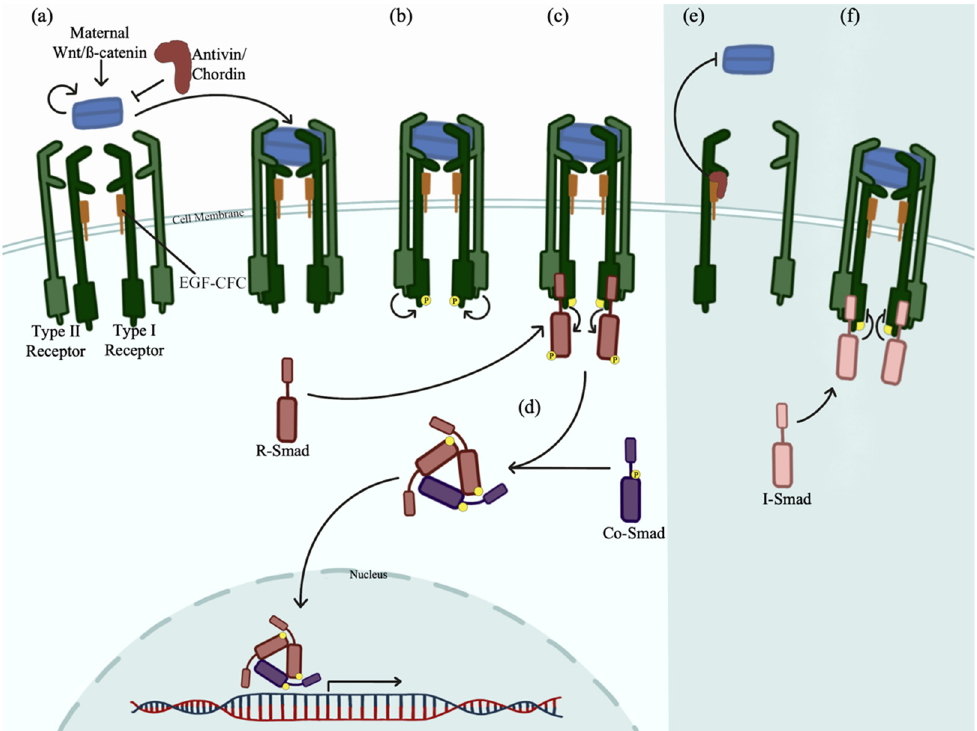
Figure 1. TGF-ß Signaling. TGF-ß ligands Nodal and Bmp activate Smad signaling. ( a ) Maternal Wnt/ß-catenin signals Nodal or Bmp ligands. These ligands bind and assemble the type I and type II heteromeric receptor complex. EGF-CFC co-receptors are bound to type I receptors. ( b ) Ligand binding transduces the signals intracellularly. Type II receptors phosphorylate type I receptors signaling Smad proteins. ( c ) R-Smad proteins are phosphorylated by type I receptors. Nodal specific R-Smads are Smad2 and 3. Bmp specific R-Smads are Smad1, 5, and 9. ( d ) Two R-Smads complex with one phosphorylated co-Smad4 and translocate into the nuclease and activate gene transcription. ( e ) Antivin or Chordin inhibits Nodal or Bmp, respectively, by binding to the EGF-CFC co-receptor on the type I receptor blocking ligand binding to the receptor. ( f ) After receptor phosphorylation, I-Smad6 or 7 can bind to the receptor complex blocking R-Smad binding and signaling.